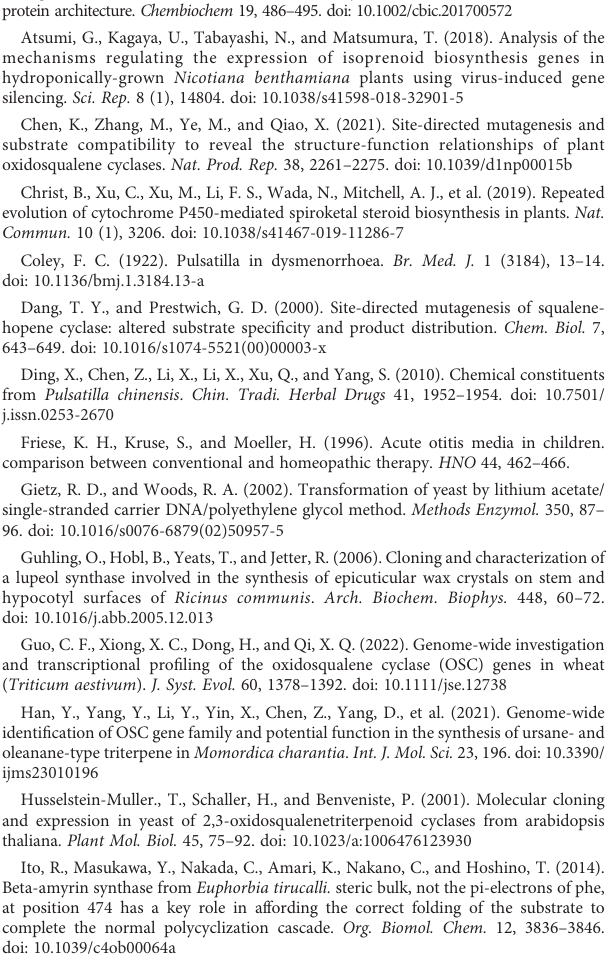
SUPPLEMENTARY FIGURE 2 Phylogenetic analysis of PcAS and PchAS with the OSCs of other species. SUPPLEMENTARY FIGURE 3 Sequence alignment of AS proteins from Nigella sativa ( NsAS ), Pulsatilla ceruna ( PcAS ) and Pulsatilla chinensis ( PchAS ) . SUPPLEMENTARY FIGURE 4 GC-MS analysis of b -amyrin and lupeol standard and the contents of PcAS and PchAS catalysate. The 218 and 189 ion counts of b -amyrin and lupeol are shown, respectively. SUPPLEMENTARY FIGURE 5 Functional characterization of mutant protein of I337V, H296D, Q397P. (A) GC – MS analyses of the yeast extraction expressing the mutant proteins contain the I337V with/without other sites; (B) GC – MS analyses of H296D,